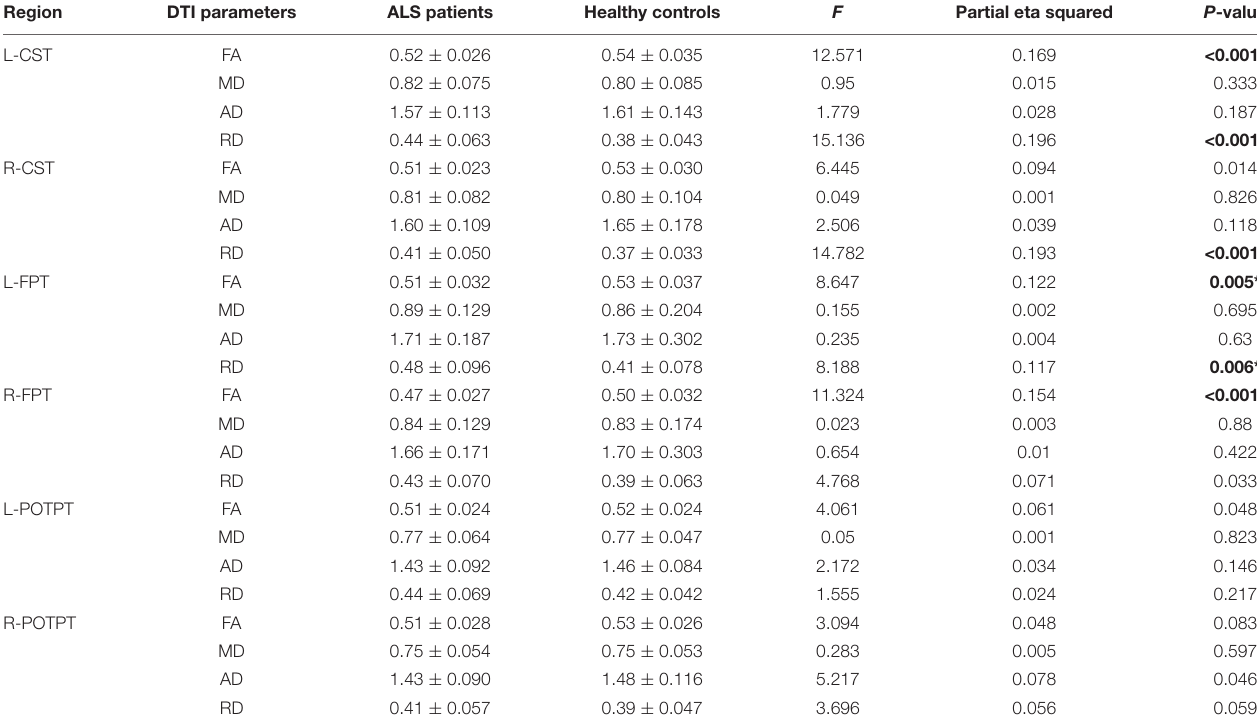
TABLE 3 | Group comparisons of the mean DTI parameters in ALS patients and healthy controls. Region DTI parameters ALS patients Healthy controls F Partial eta squared P